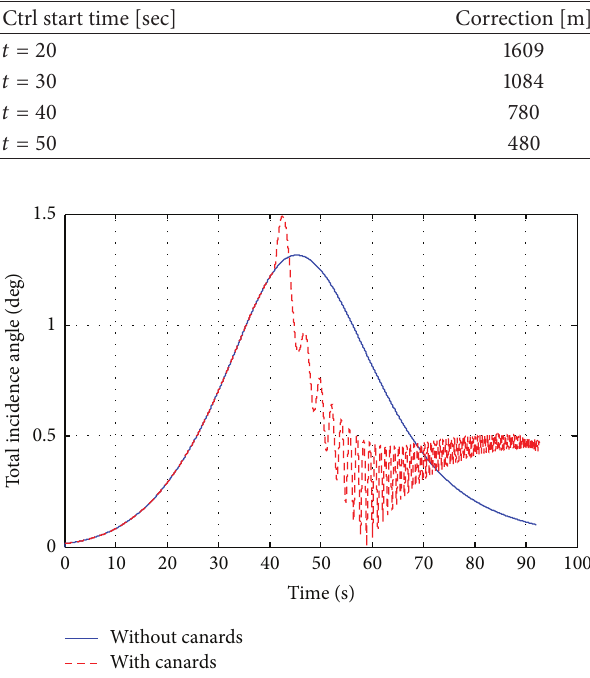
Figure 12: Total incidence angle, 𝛼 𝑡 , versus time.